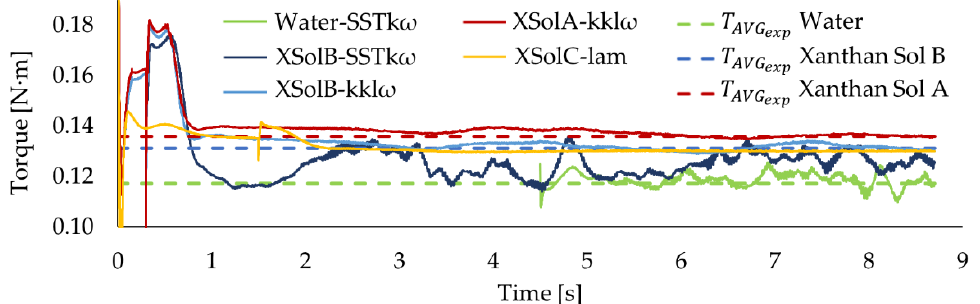
Figure 7. Simulated torque for the abiotic systems.